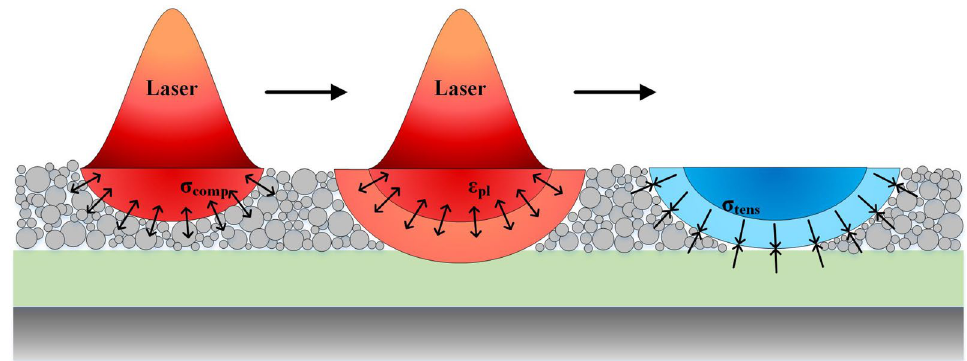
Figure 17 Temperature gradient mechanism in